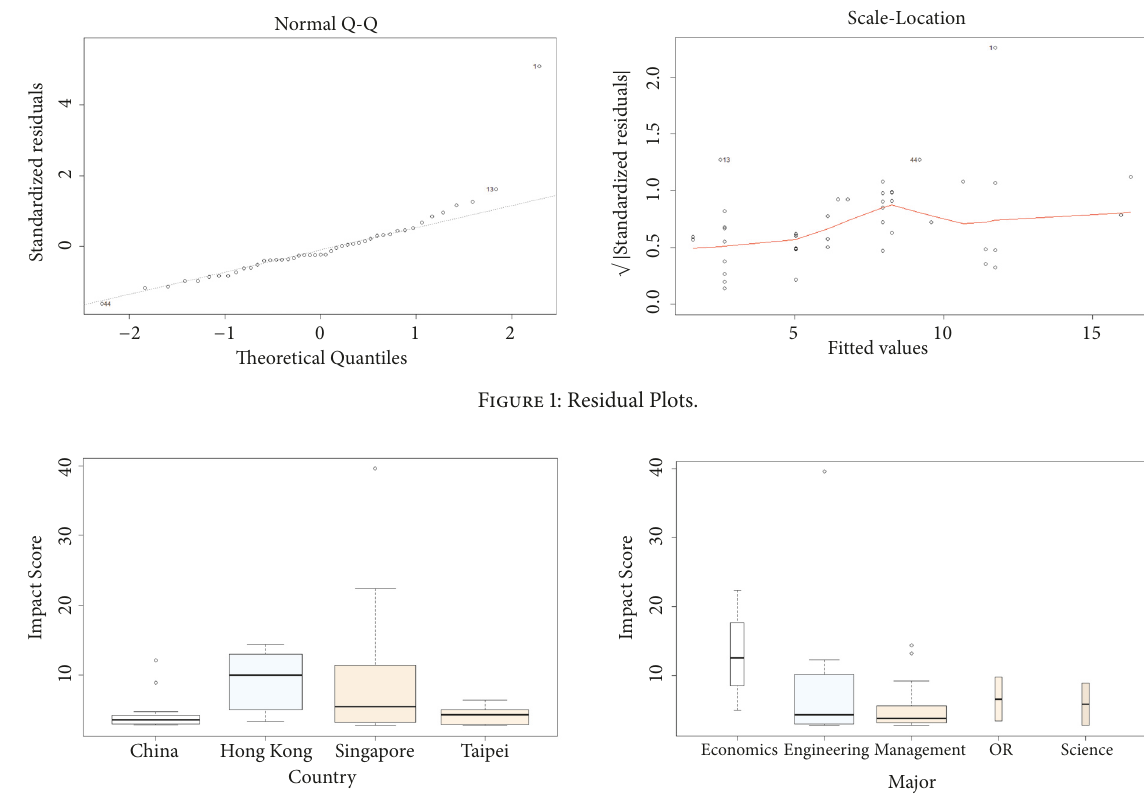
Figure 2: Impact score by country and major in